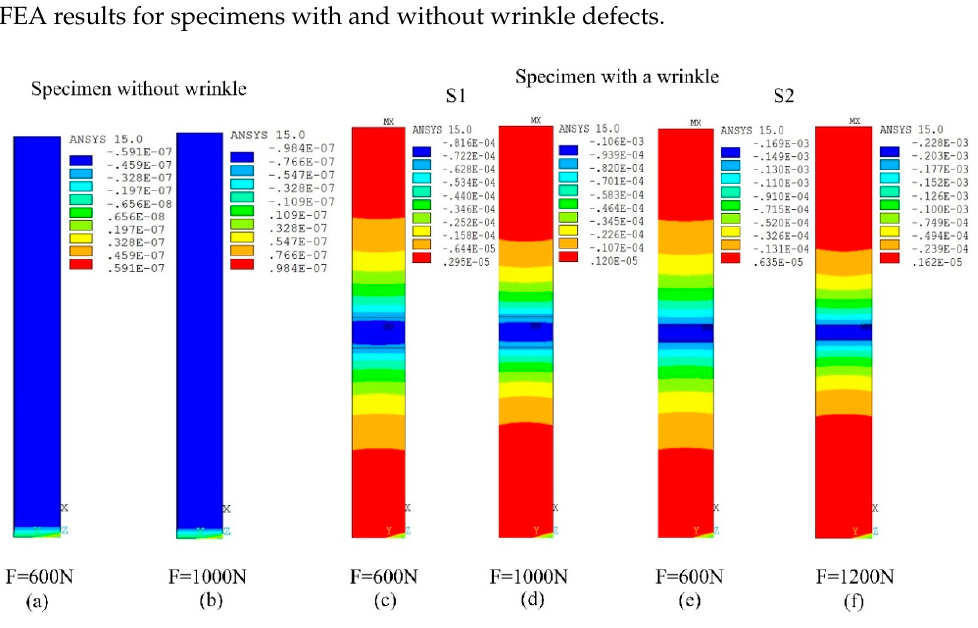
Figure 11. FEA simulation for specimens with/without wrinkle defects. Figure 11a,b illustrate the out-of-plane displacement without defects, where the dis- placement field is uniformly smooth and the displacements are 0.591 × 10 − 4 mm and 0.984 × 10 − 4 mm, corresponding to tensile forces of 600 N and 1000 N,